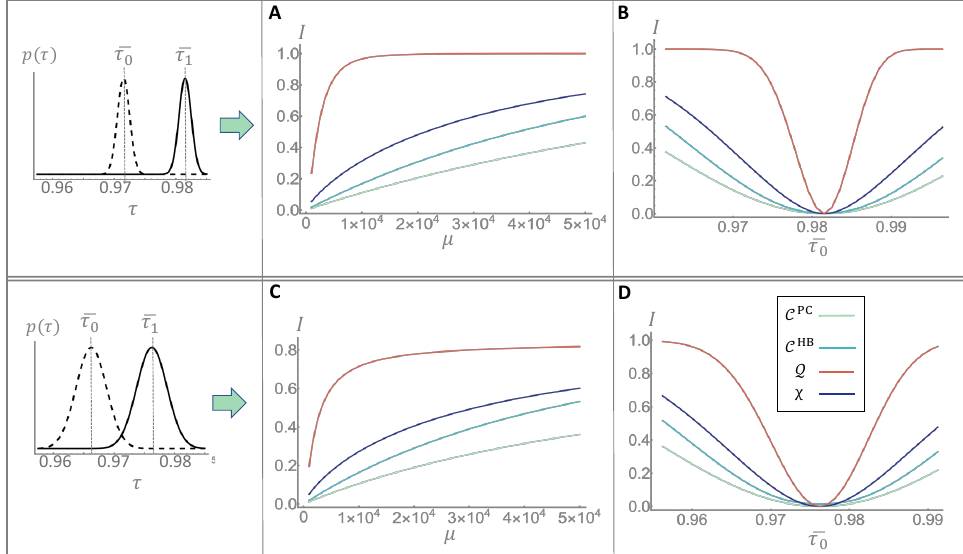
�𝜏𝜏 0 Figure 2. Comparison of information recovery. We compare the information recovered with the three classical strategies and the quantum one, described in the main text, for two different con- figuration of the trasmittance distributions g 0 ( τ 0 ) and g 1 ( τ 1 ) , both assumed gaussian. In the fist row, we fixed the mean value of g 1 to ¯ τ 1 = 0.982 and the standard deviations of the distributions to σ 1 = σ 0 = 0.001. In panel ( A ), the mean value of g 0 is fixed to ¯ τ 0 = 0.972 and the informations are showed as a function of the mean number of signal photons µ . In all the panels we report the quantum recovered information Q in red, the global classical bound χ in dark blue, the local classical bound C HB in light-blue and the photon counting classical performance in light green. In panel ( B ) we fixed the photon number to µ = 10 4 and we showed the information in function of ¯ τ 0 . In the second row, we set different transmittance distributions, in order to increase their overlap, with (panel ( C )) ¯ τ 1 = 0.976, ¯ τ 0 = 0.966 and σ 1 = σ 0 = 0.0025. In panel ( D ) we fix µ = 10 4 and let ¯ τ 0